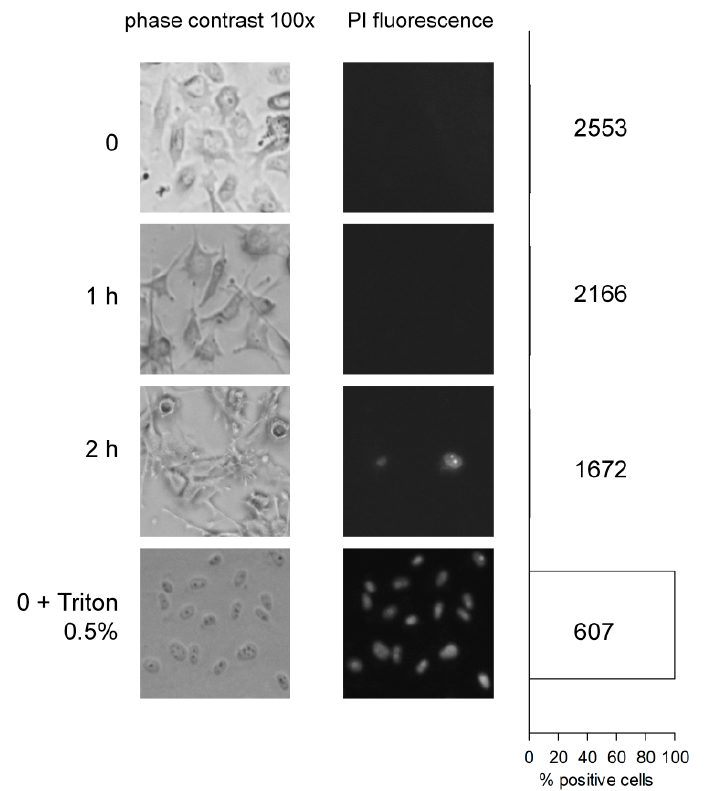
Figure 4. Effect of incubation under agitation in Hank’s balanced salt solution containing BK (500 nM) on adherent HUVECs (matched phase contrast and red fluorescence fields, original magnification 100×). Propidium iodide (PI) staining was performed as a test of viability (positive control, Triton X100, 0.5%). Total counted cell numbers are given next to the histograms.